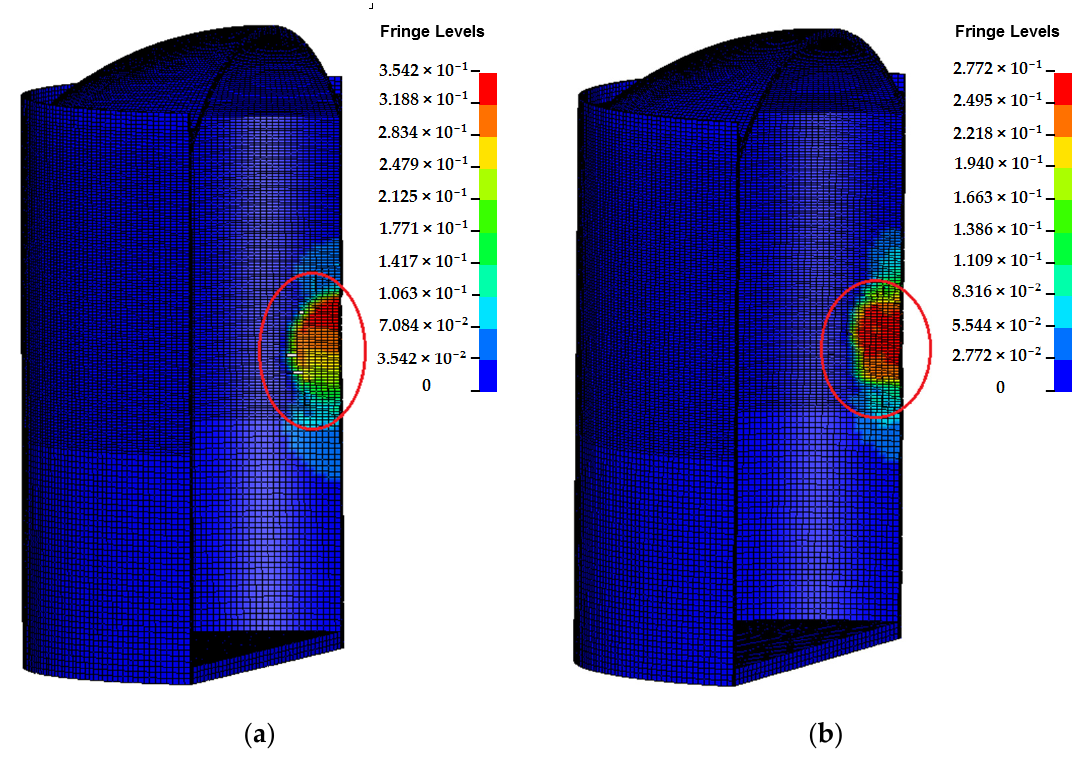
Figure 13. Contours of the maximum impact displacement and concrete peeling off area of full SC containment. ( a ) Vs = 1000 m/s. ( b ) Vs = 2000 m/s.